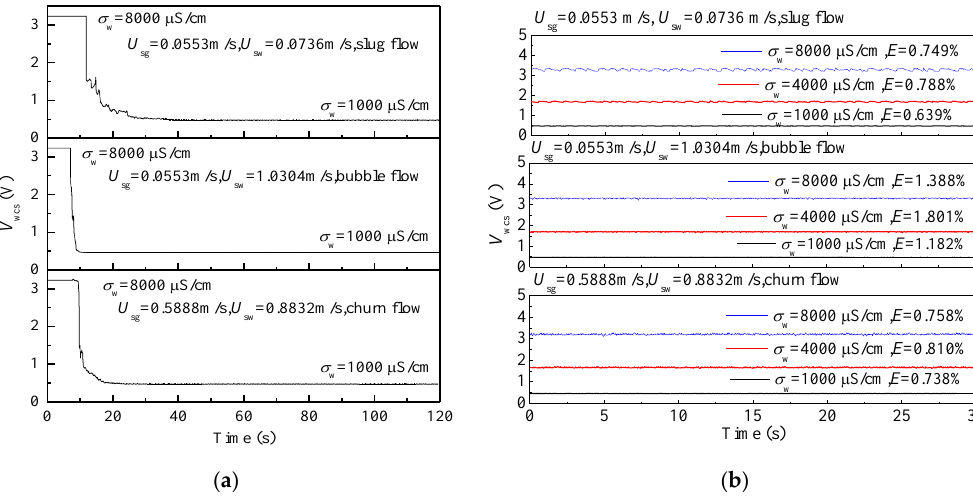
Figure 7. The performance of the water conductivity sensor to water conductivity measurement: ( a ) The sensor responses to the water conductivity change (from 8000 μS/cm to 1000 μS/cm ) under different flow patterns; ( b ) The sensor outputs under different flow patterns and water conductivities.